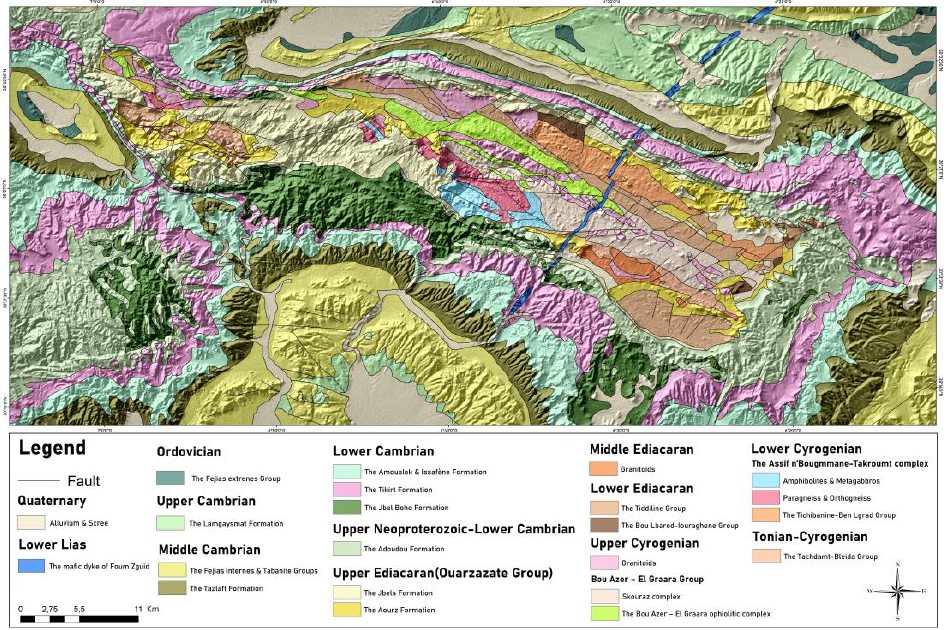
Figure 2. Geological setting of Bou Azzer inlier after 1/50,000 geological maps of Aït Ahmane and Alougoum modified after [26]. Alougoum modified after